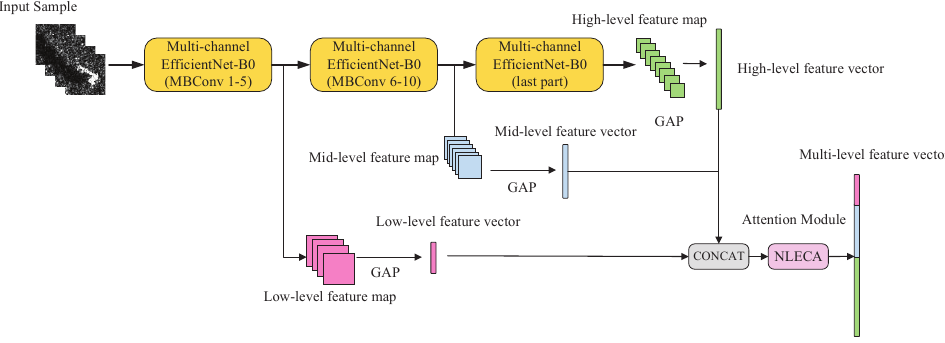
Figure 8. Schematic diagram of multi-level feature extraction and